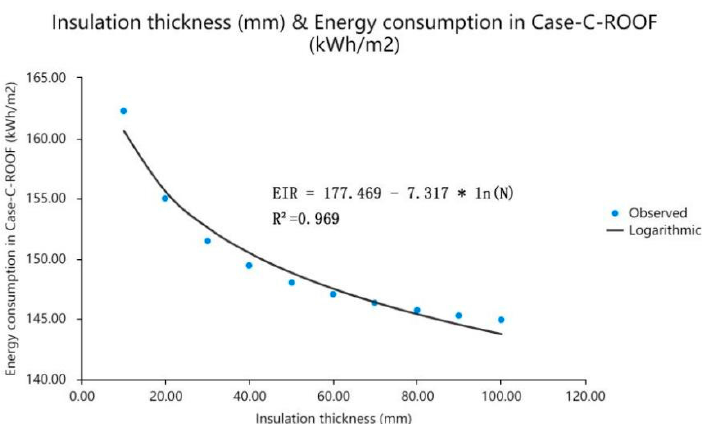
Figure 14. Logarithmic curve of EIR and N.